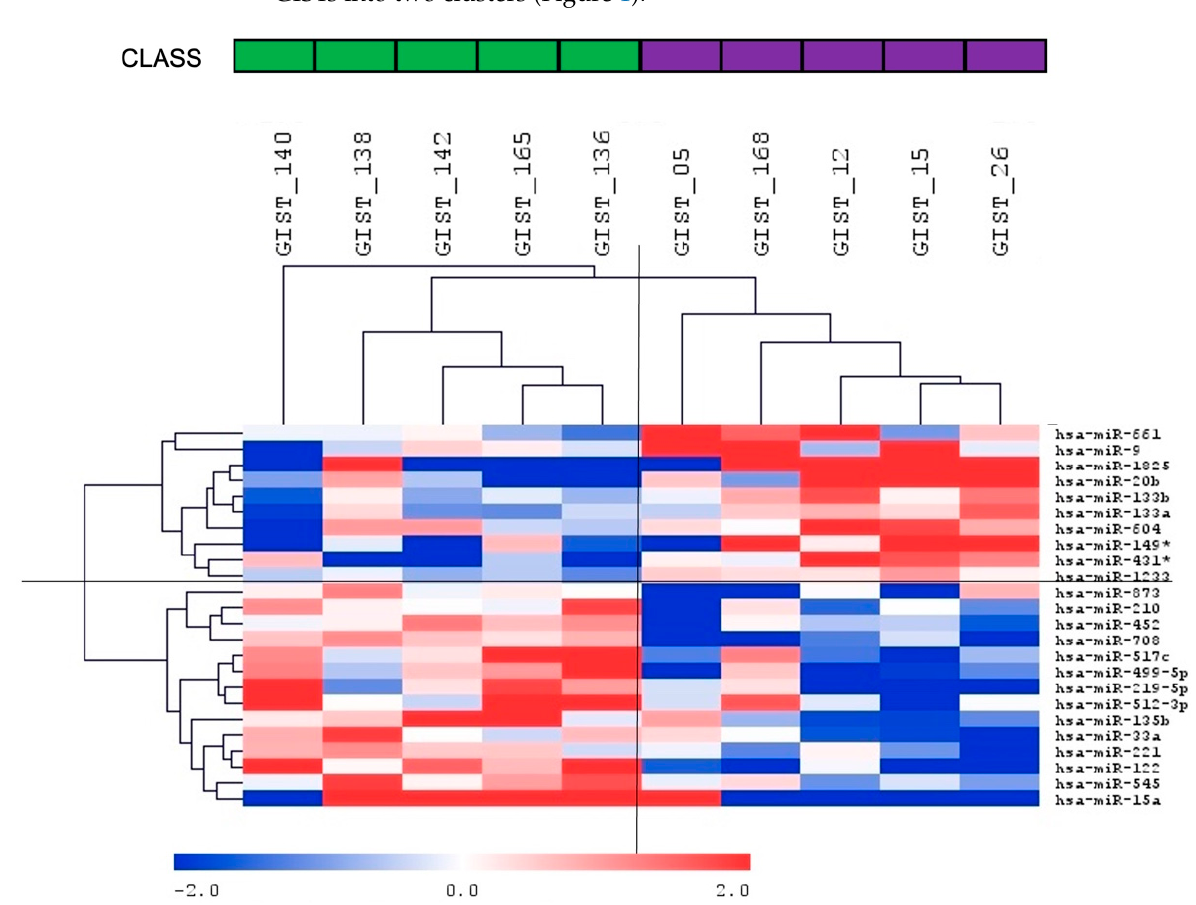
Figure 1. miRNA hierarchical clustering. The heatmap shows miRNAs identified as differentially expressed between PDGFRA D842V mutant GISTs compared to non-D842V mutant GISTs. * indicates 3p (i.e. miR-149-3p; miR-431-3p) Pathway enrichment analysis of the 24 deregulated miRNAs was performed using the miRNet tool; functional enrichment analysis is based on gene ontology (GO) terms or pathways according to Reactome databases [22]. Results are reported in the Supplemental